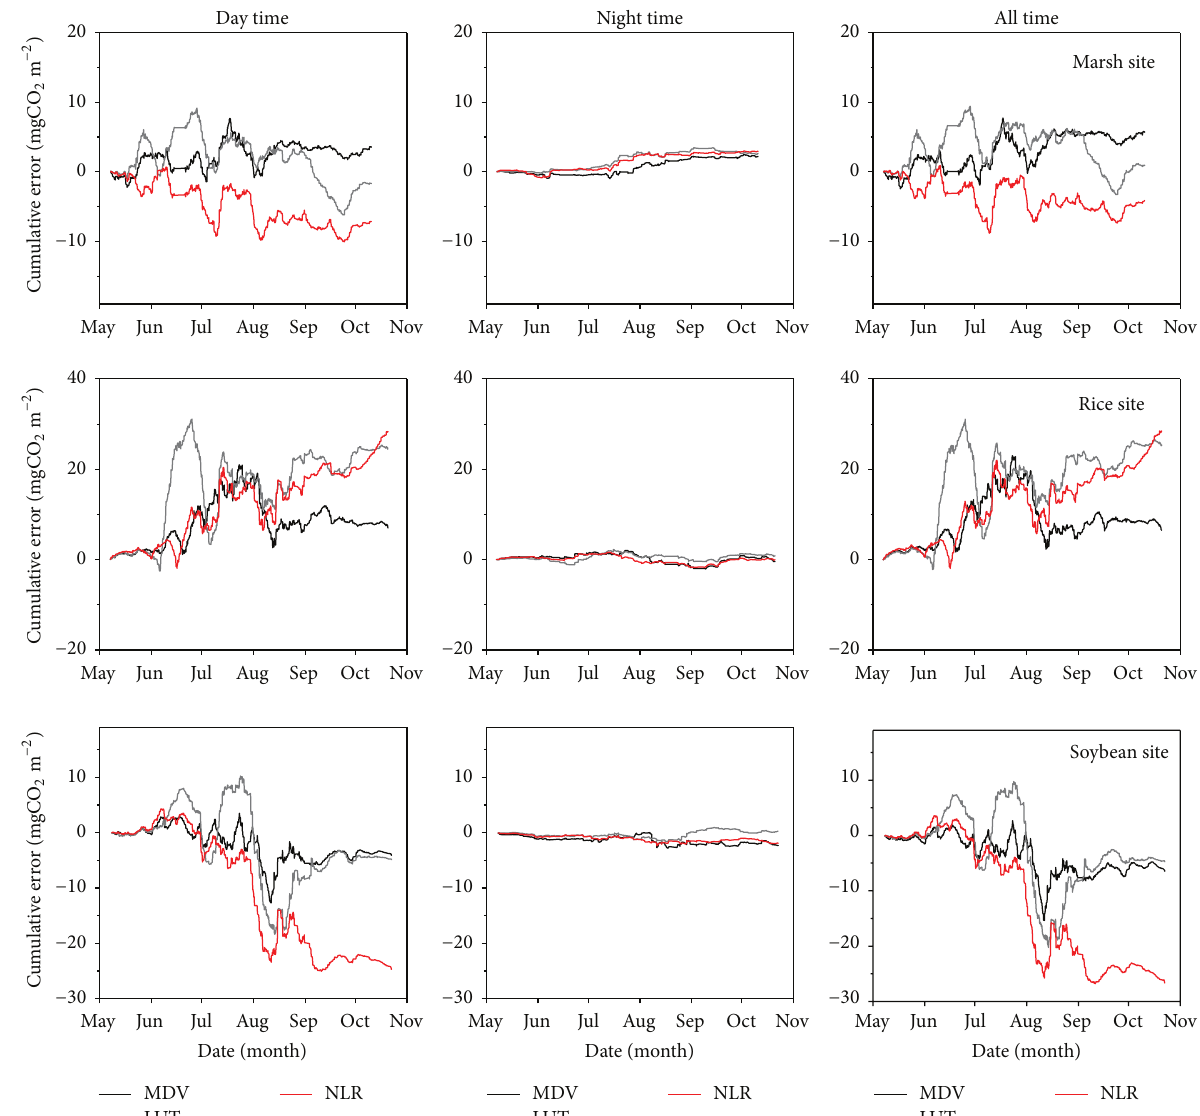
Figure 5: Cumulative error in gap-filled NEE from May to October, separated in daytime, nighttime, and all time contribution, at marsh, rice, and soybean